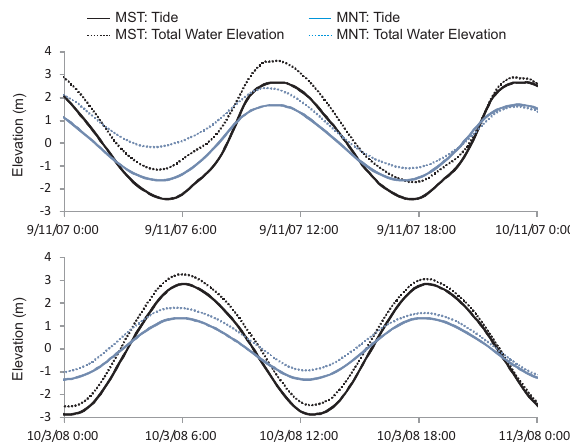
Fig. 7. Time series of tide and total water elevation for mean neap and spring tide (M2-modulated on the boundaries) at Dunkerque for the November 2007 event (above), and Le Conquet for the March 2008 event (below).